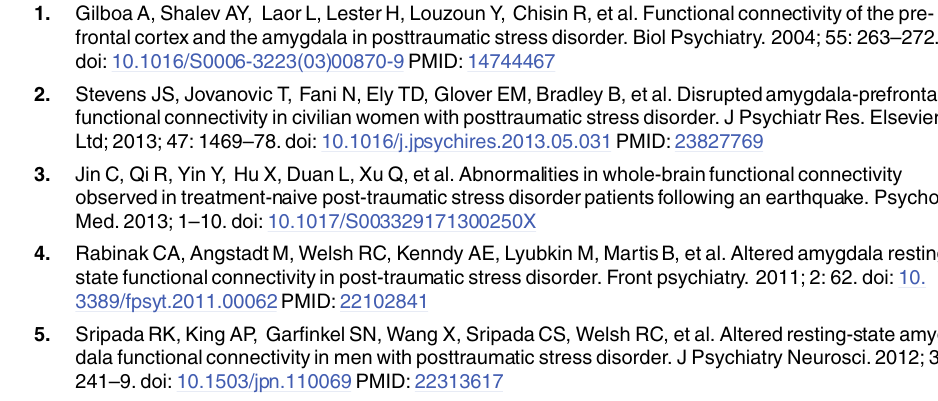
S1 Table. Example of personalizedtrauma-related words and neutral words. Example of personalized trauma-related (stress-related for controls) words and neutral words used for stimulus presentation during the task in the fMRI scanner. As shown in the table, trauma- related and neutral words were matched for letter/syllable